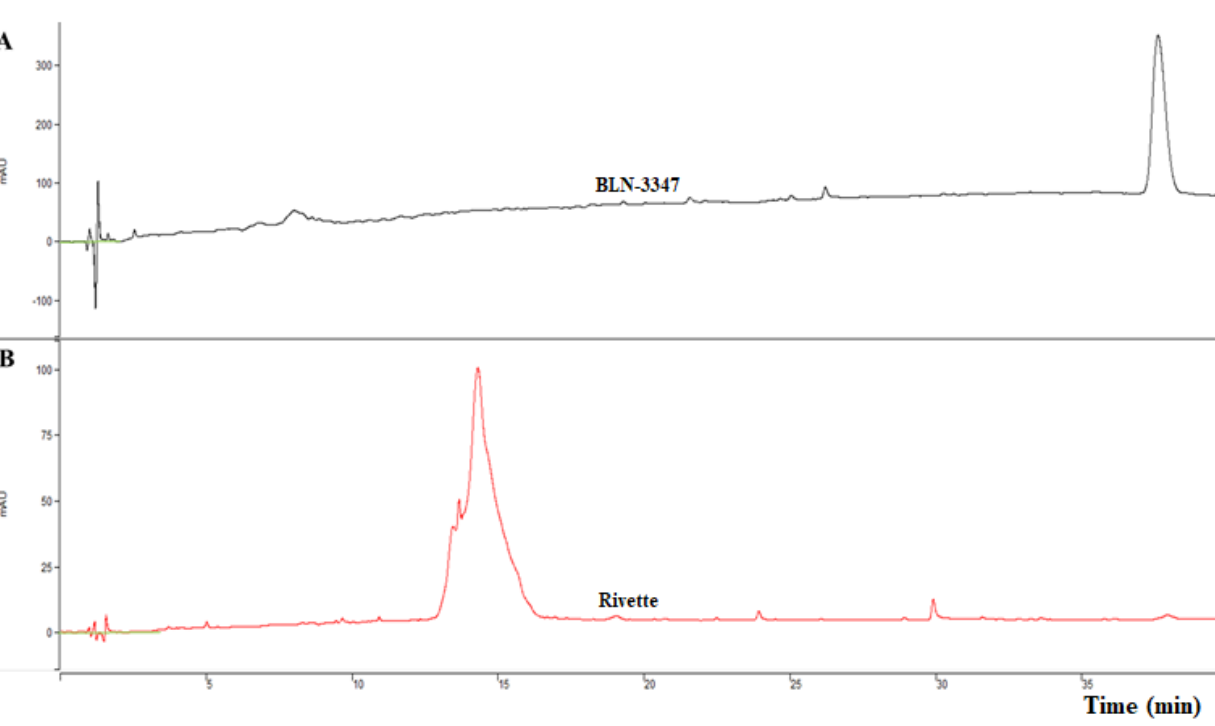
Figure 3. RP-HPLC (214 nm) elution profiles of canola protease inhibitor samples from BLN-3347 ( A ) and Rivette ( B ). Absorbance (mAU) was measured at 214 nm by Y-axis. Retention time in minutes (min) was measured along with fraction collection by